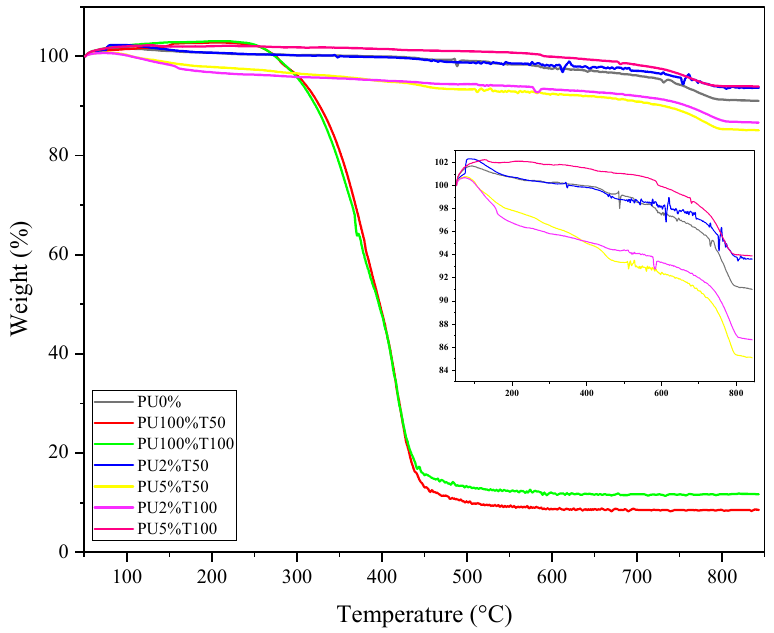
Figure 10. TGA of the samples of PU, polyurea mortars, and control mortar (PU0%).